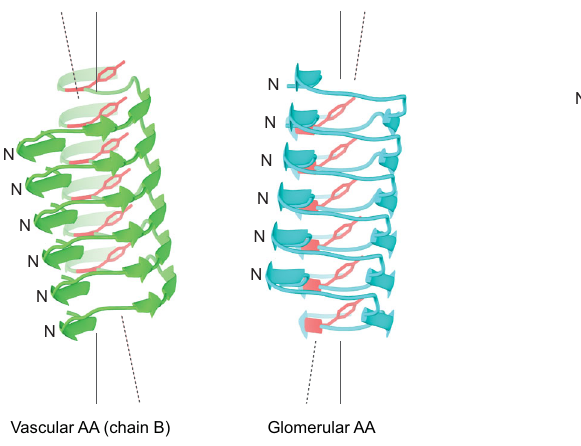
effectofthehandednessofthe fi brilonthetiltofthe β -strandsrelativetothe z -axis. Theredlinesaredrawntohighlighttheangulartiltofthe β -strands.Thecontinuous black line indicates the fi bril z -axis.